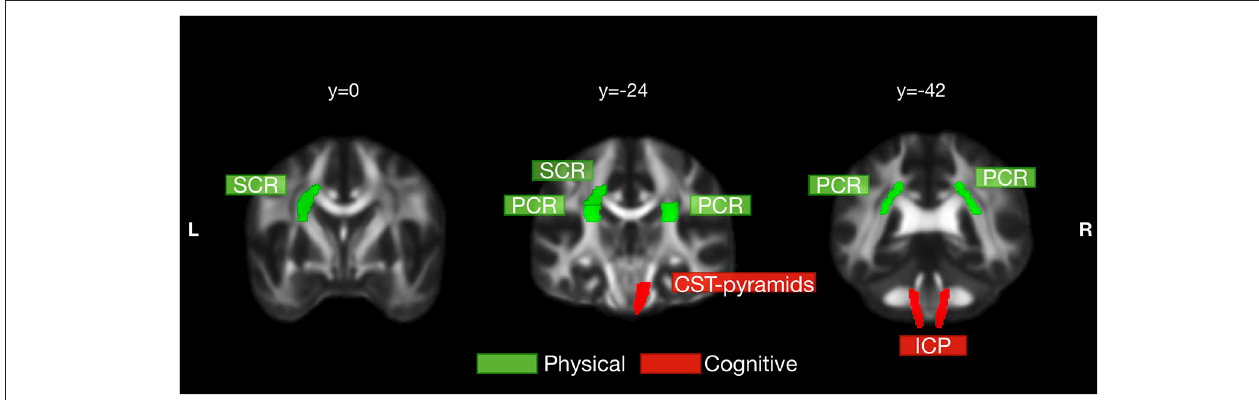
FIGURE 3 | Physical activity- and cognition-related white matter tracts in SCD. White matter tracts that significantly correlated with physical activity and cognition were labeled in green and red, respectively. Physical activity was significantly correlated with left superior corona radiata (SCR) and bilateral posterior corona radiata (PCR). Cognitive performance was significantly correlated with bilateral inferior cerebellar peduncle (ICP) and right pyramids segment of corticospinal tract (CST pyramids). Right CST pyramids and right PCR had overlapped correlations with both physical activity and cognitive performance but still were more cognition- and physical activity-related, respectively. The tracts in this figure were those with at least one correlation coefficient at a FDR-corrected p < 0.05 to either physical activity or cognitive performance.